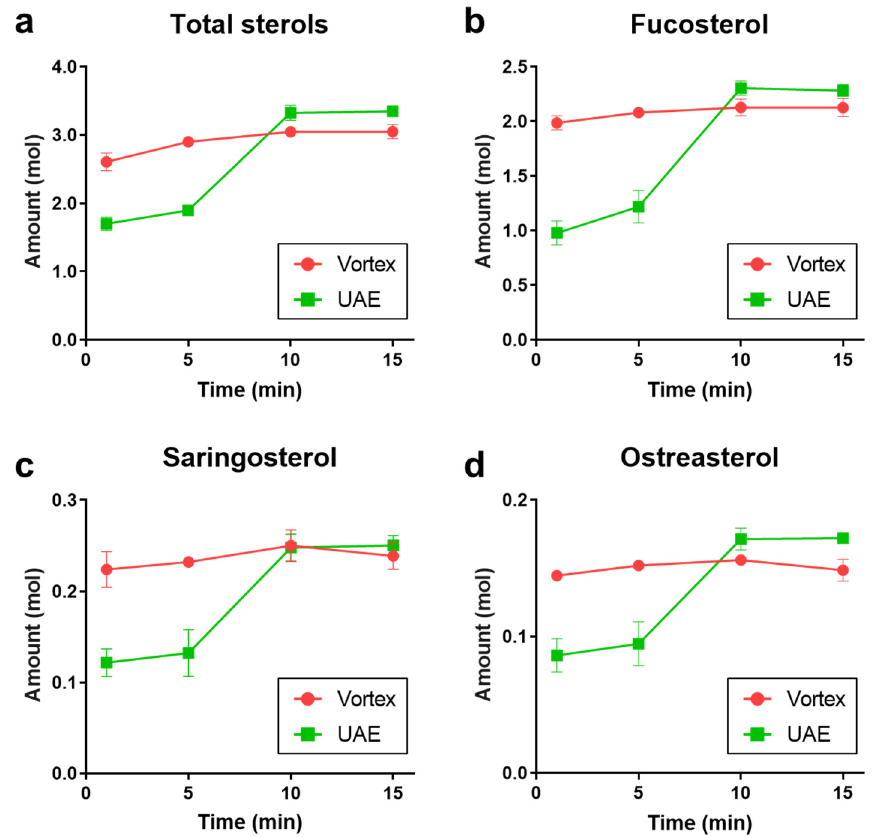
Figure 3. Comparison of extraction efficiency between vortex and UAE. ( a ) Total phytosterol; ( b ) Fucosterol; ( c ) Saringosterol; ( d ) Ostreasterol.